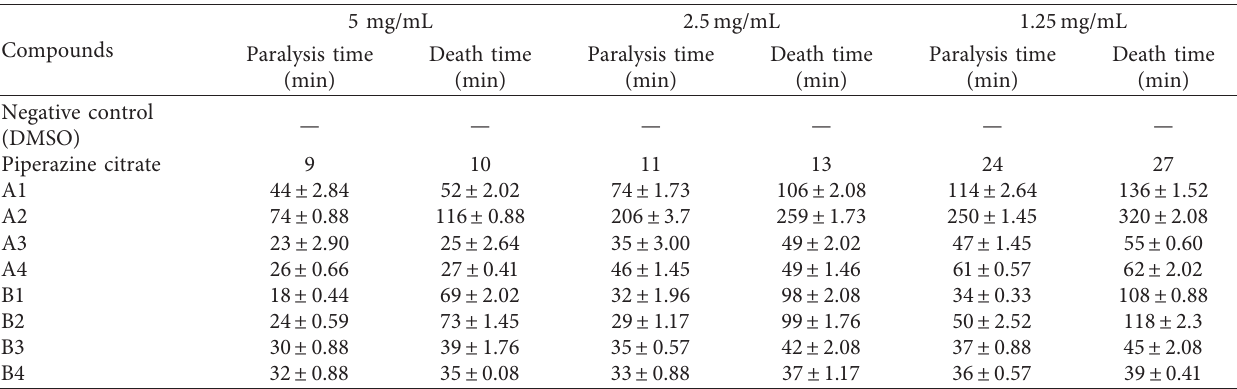
Table 2: Anthelminthic activity.